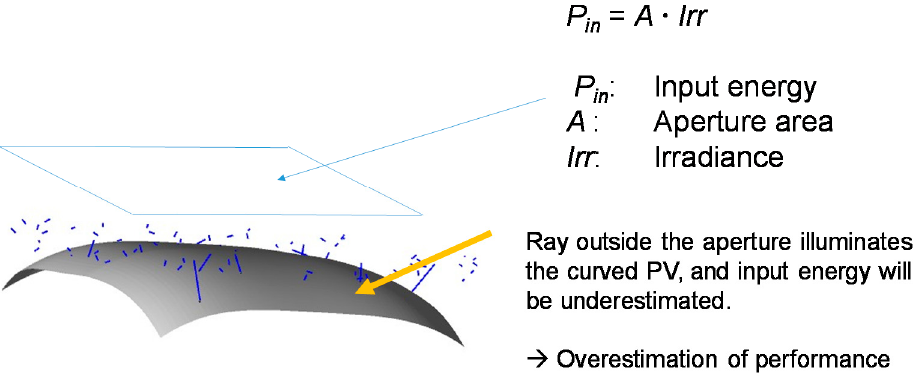
Figure 4. Illustration of the underestimation of the input energy in the measurement of the curved PV module.